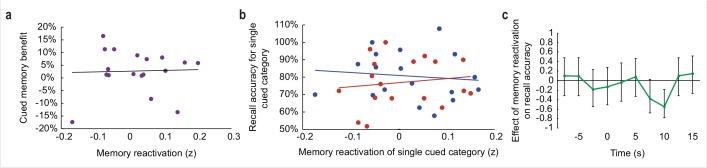
Relationship between within-sleep odor-evoked memory reactivation in hippocampus and posttest memory retention.(a) The degree to which odors elicited memory reactivation in an anatomical region of interest in hippocampus did not predict enhancement of cued visuospatial recall accuracy at posttest (r(16) = 0.03, p = 0.91). (b–c) Illustration of the correlation between memory reactivation in hippocampus and memory performance for (b) the two reactivated object categories computed separately (blue, r(16) = −0.11, p = 0.66; red, r(16) = 0.14, p = 0.58), and (c) shown across time points. Time 0 is aligned to odor onset. Error bars depict 90% confidence intervals.10.7554/eLife.39681.016Figure 3—figure supplement 1—source data 1.Relates to panel (a).10.7554/eLife.39681.017Figure 3—figure supplement 1—source data 2.Relates to panel (b).10.7554/eLife.39681.018Figure 3—figure supplement 1—source data 3.Relates to panel (c).